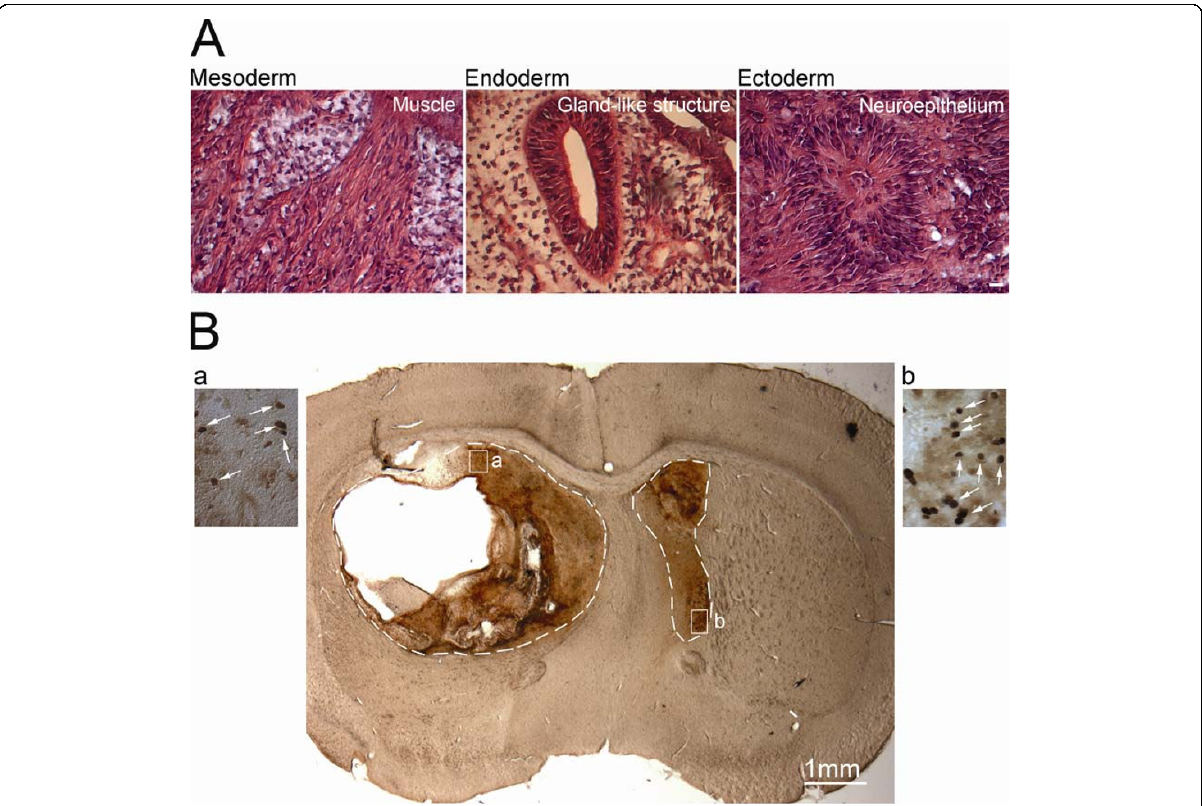
Figure 5 Teratoma derived from TrES1 and expression of mutant htt in striatal graft of TrES1 . Undifferentiated TrES1 and TrES1 derived NPCs were implanted into the striatum of SCID mice and recovered at six weeks for morphological and immunohistochemical analysis. (A) Hematoxylin and eosin staining of teratoma derived from undifferentiated TrES1. (B) Undifferentiated TrES1 (Left hemisphere) and TrES1 derived NPCs (Right hemisphere) were implanted into contralateral hemispheres of SCID mice. Immunohistochemical staining using mEM48 revealed the expression of mutant htt in both hemispheres (B-a and B-b). Areas surrounded by interrupted line indicated the locations of the cell